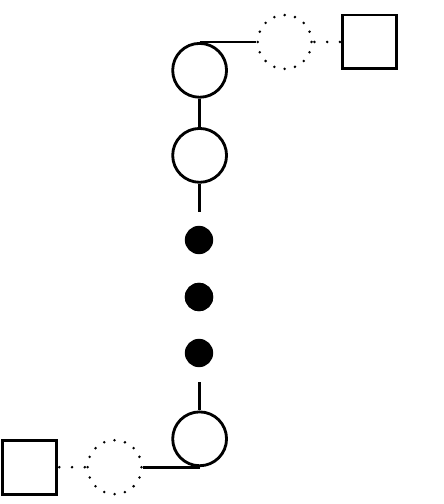
Figure 10. Typical quiver diagram for A k (cid:0) 1 type. The left E-string and the right E-string should be at the bottom and the right E-string at the